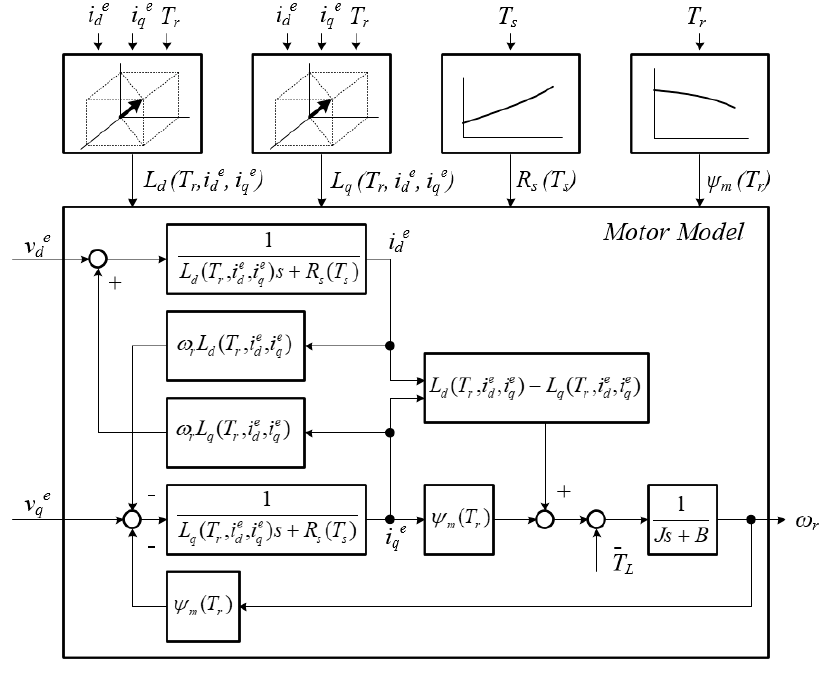
Figure 10. Motor simulation model.